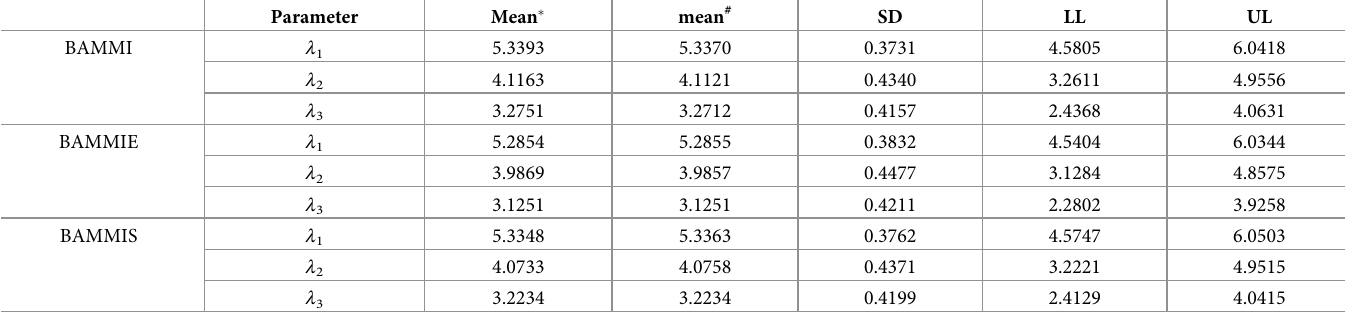
Table 4. Point estimate and interval estimate (HPD at 95% probability) for singular values for the three Bayesian AMMI versions, using the RJMCMC algorithm. Parameter Mean � mean # SD LL